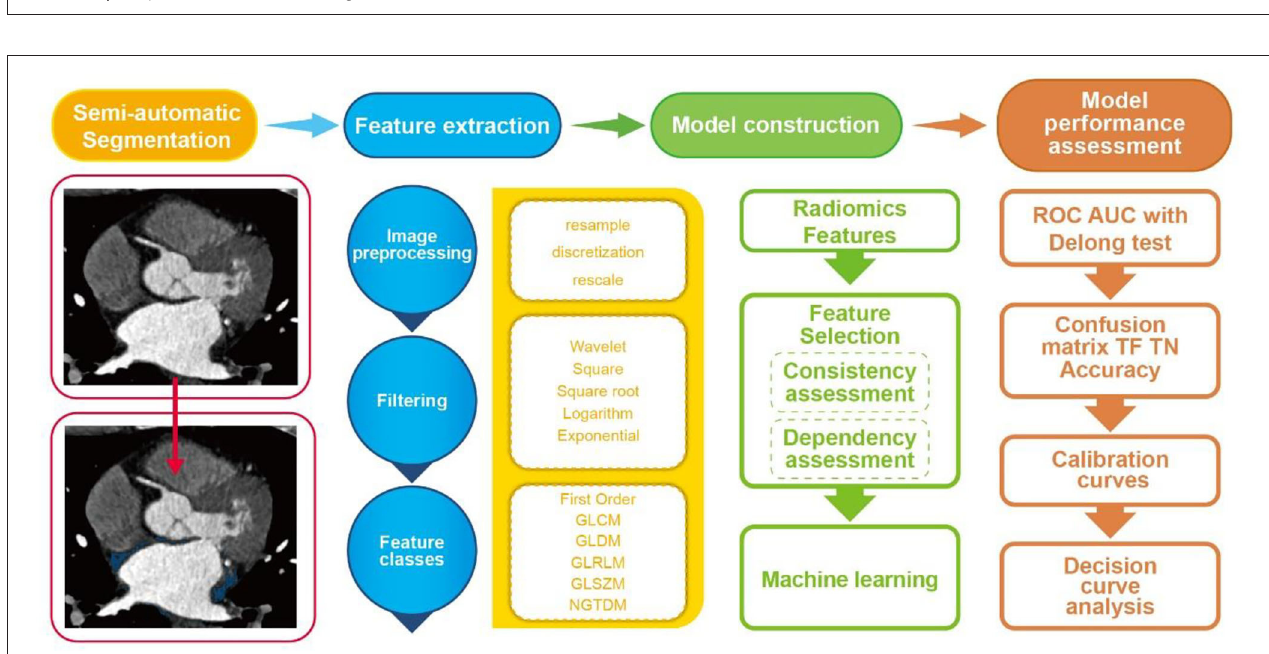
lower boundary is the coronary sinus, and manually trimmed using EAT as a reference. Then, LA-EAT was automatically identified using the threshold of − 200 to − 50 HU. Meanwhile, the EAT and LA-EAT volumes in cubic centimeters were measured ( Figure 3